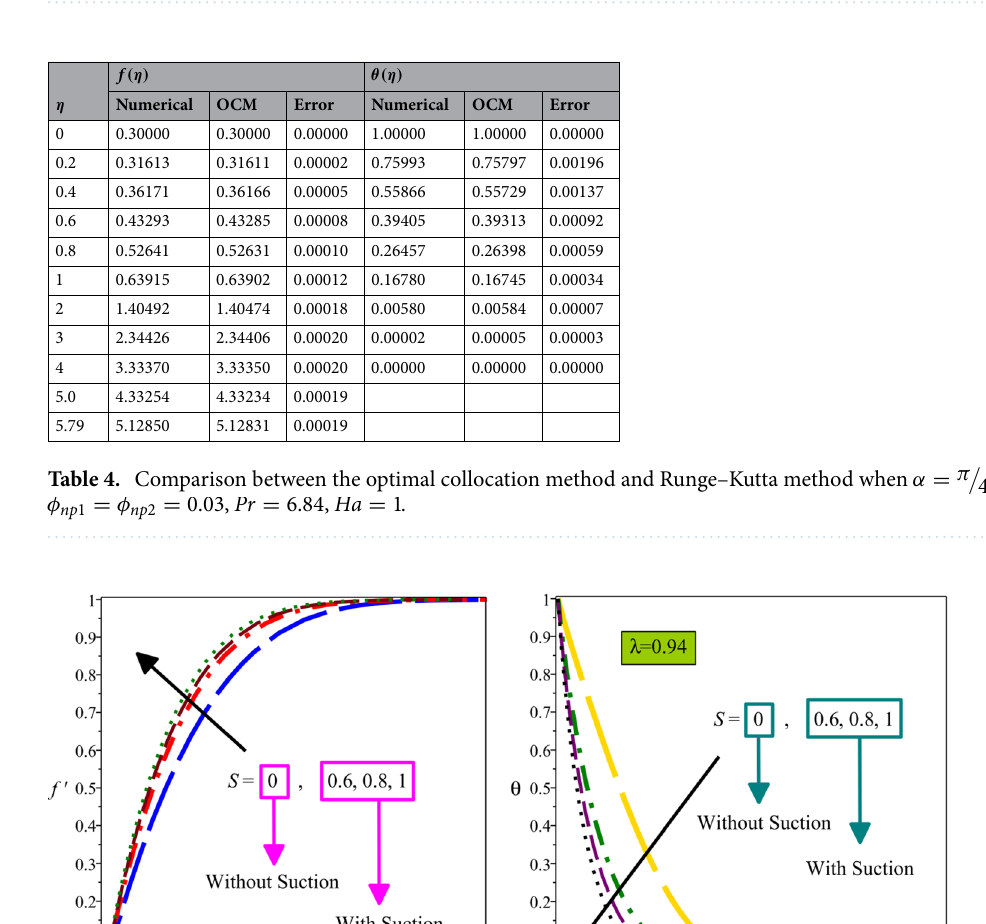
Figure 2. Comparison of current analysis with the numerical method at different ( a ) S ( b ) α .